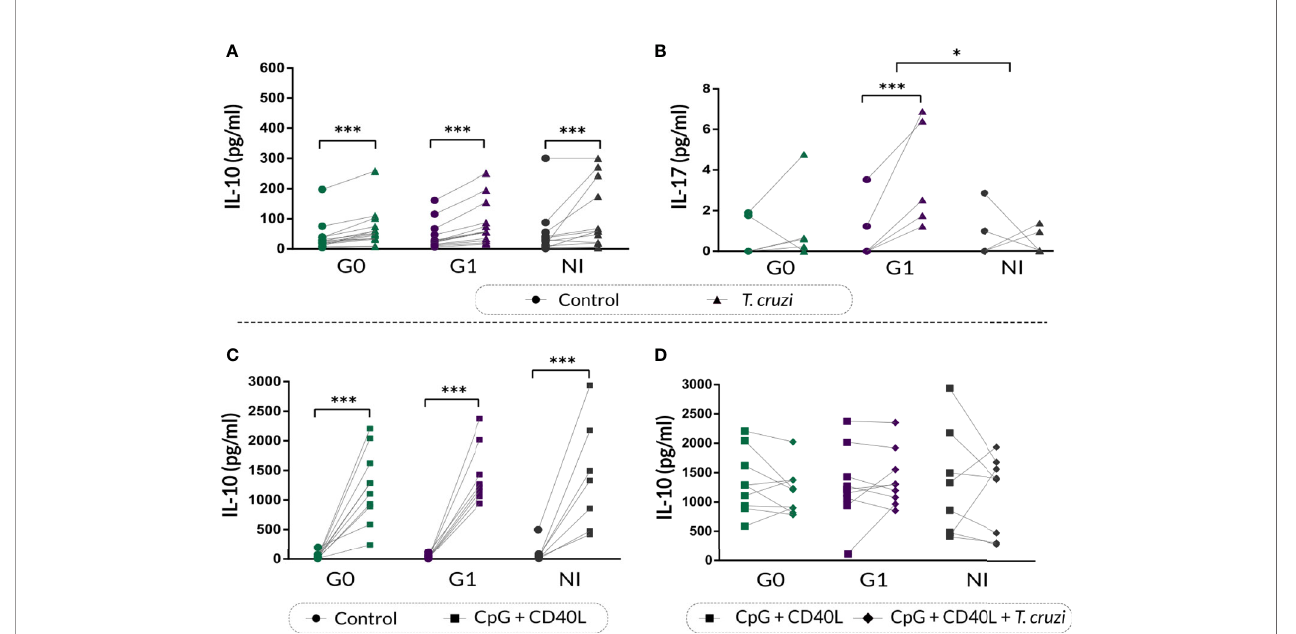
FIGURE 6 | IL-10 and IL-17 cytokine secretion on supernatant of B cells from patients with CCD and NI donors following T. cruzi or CpG + CD40L stimulation. (A, B) IL-10 and IL-17 secretion in supernatants of Control or T. cruzi – stimulated B cells from CCD patients (G0, G1) and NI donors. (C) IL-10 secretion in supernatants of Control or CpG + CD40L stimulated B cells from CCD patients and NI donors. (D) IL-10 secretion in supernatants of B cells following stimulation with CpG + CD40L or CpG + CD40L + T. cruzi in CCD patients and NI donors. Each symbol represents data from one individual. Statistically signi fi cant differences are indicated with asterisks (*) p < 0.05, (***) p <